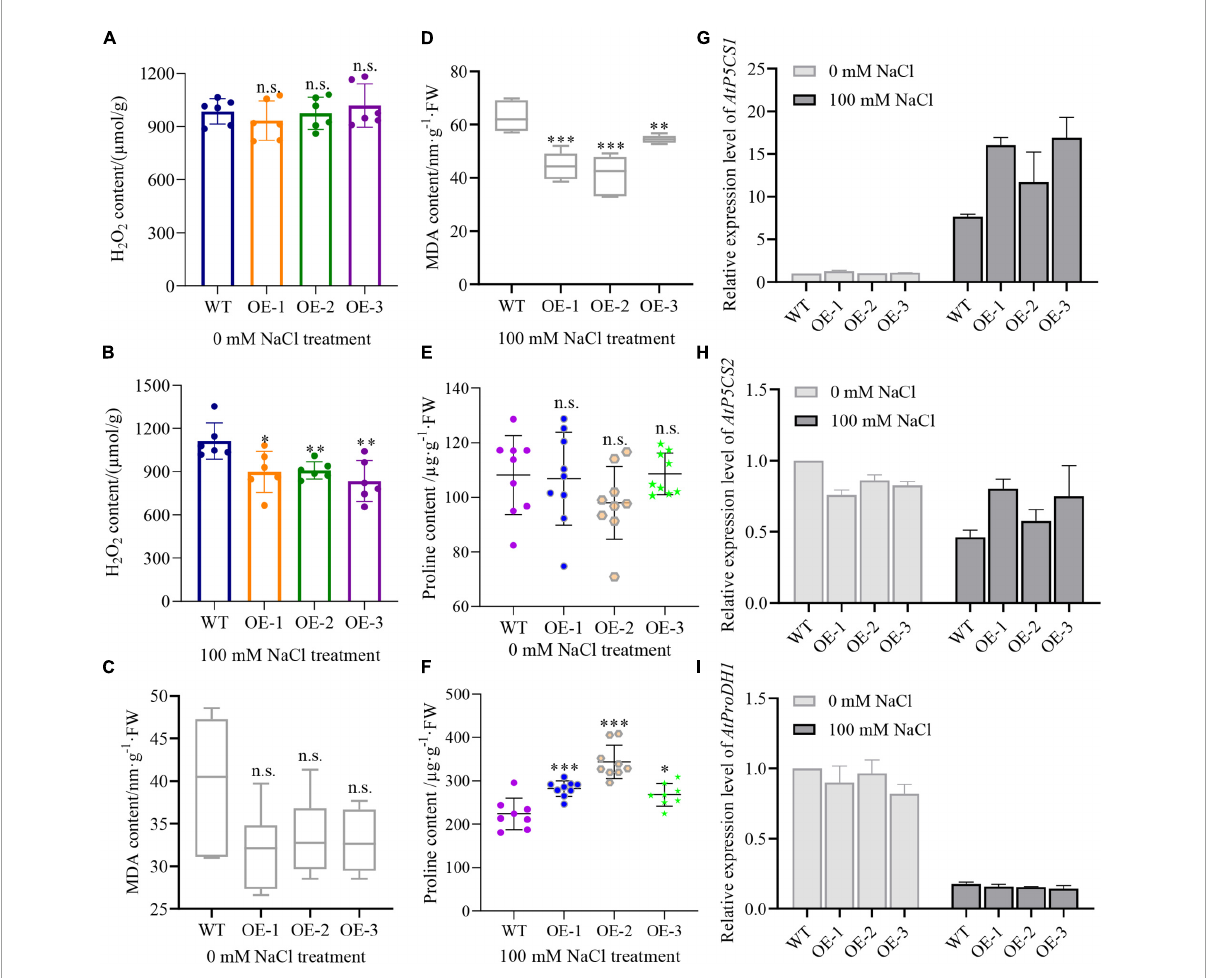
FIGURE9 NbCIPK25 overexpression leads to higher proline but lower H 2 O 2 and MDA content. (A–F) H 2 O 2 , MDA, and proline content of the 5-day-old seedlings treated with 0 mM NaCl or 100 mM NaCl for 3 days. Data represent means ± SD, three biological replicates, a t -test was used to determine statistical significance, “ ∗ ” p < 0.05, “ ∗∗ ” p < 0.01, “ ∗∗∗ ” p < 0.001, n.s.: not significant. (G–I) P5CS1 (G) , P5CS2 (H) , and ProDH1 (I) transcript levels as determined by qPCR for the 5-day-old WT and NbCIPK25 overexpressing plants treated with 0 mM NaCl or 100 mM NaCl for 2